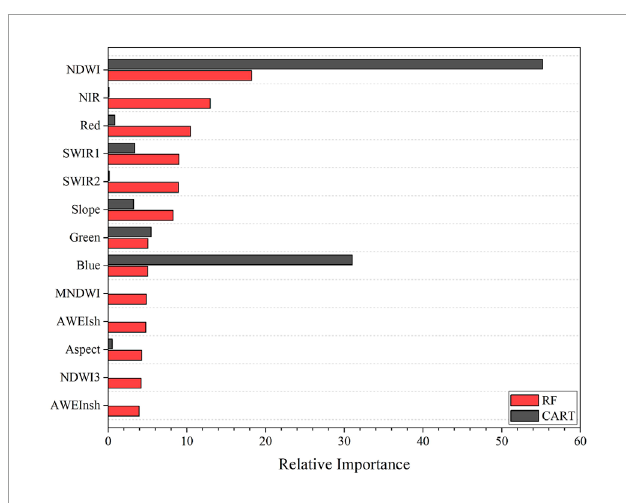
FIGURE 6 The relative importance of each feature variable from RF and CART.